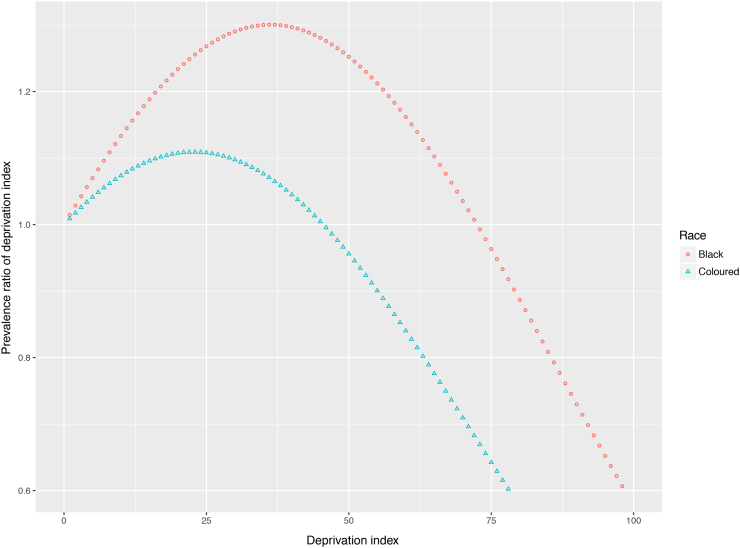
Scatterplot of the association of neighbourhood deprivation and smoking status by race.